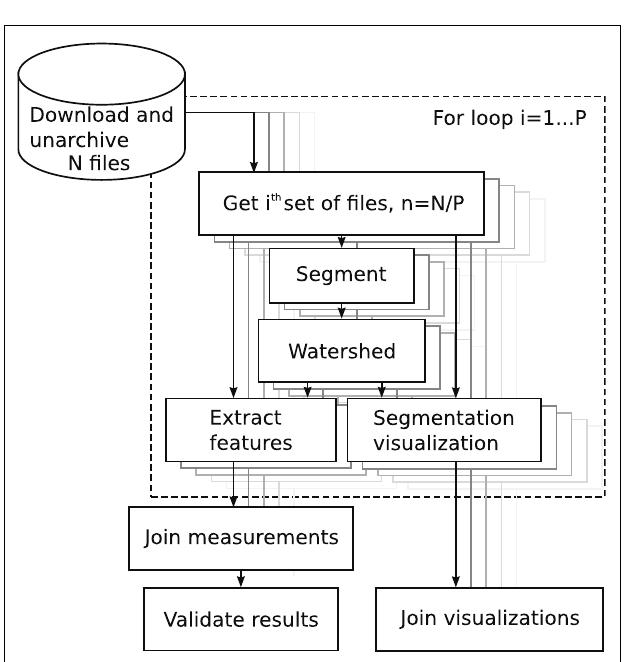
FIGURE 4 | Block diagram of the analysis of the BBBC005 image set . The source folder contains N files.The user sets the partitioning constant P to, e.g., the number of processor cores.The for-loop, in dashed rectangle, iterates over index i , automatically parallelizing the components.